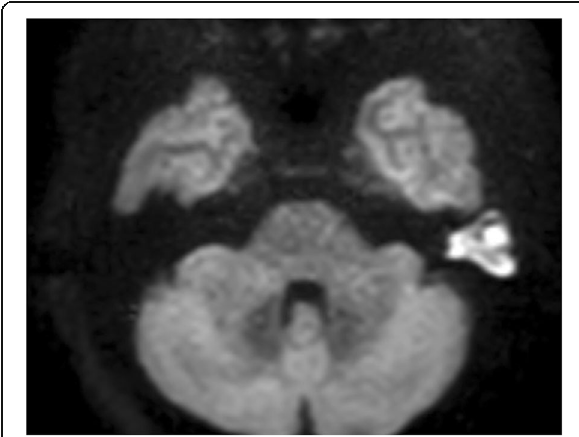
Fig. 3 Diffusion-weighted MRI ( b = 800 s/mmsq) showing recurrent left cholesteatoma exhibiting bright signal within the left middle ear cavity denoting diffusion